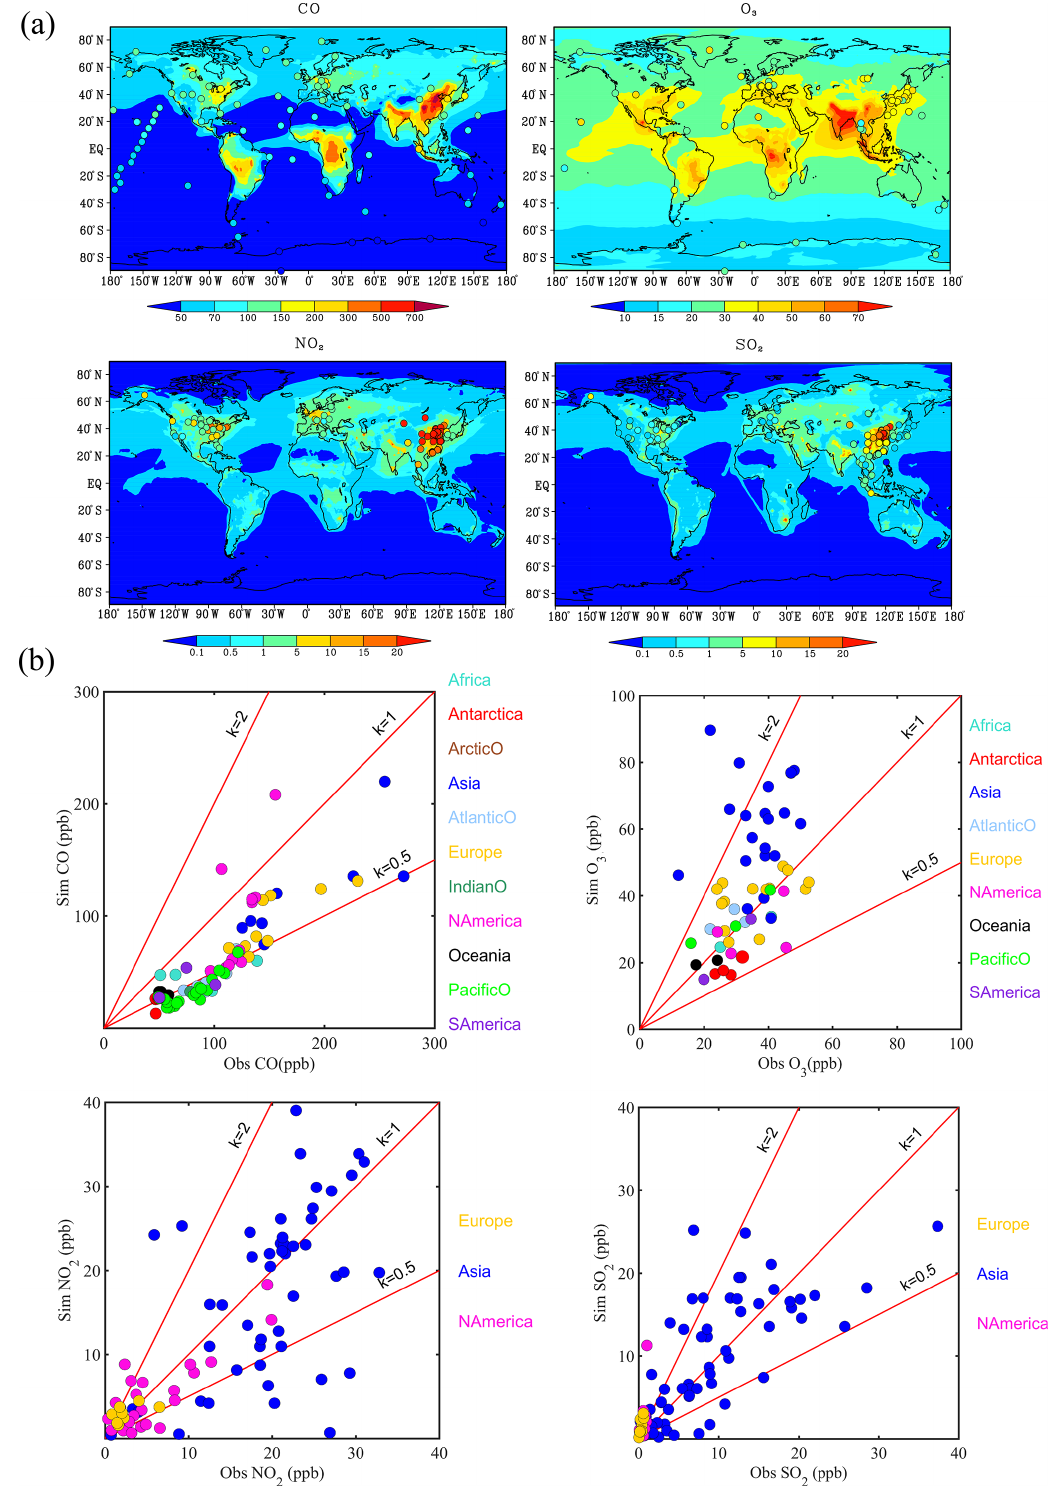
Figure 4. Annual mean concentration (ppb) of the surface layer in the IAP-AACM compared with observations. (a) The circles represent site observations. The first row is CO and O 3 , and the bottom row is NO 2 and SO 2 . (b) Scatterplots for Africa, Antarctica, the Arctic Ocean (ArcticO), Asia, the Atlantic Ocean (AtlanticO), Europe, the Indian Ocean (IndianO), North America (NAmerica), South America (SAmerica), Oceania, and the Pacific Ocean (PacificO). The abscissa shows the observations, and the ordinate shows the simulation. The colour of the points represents different